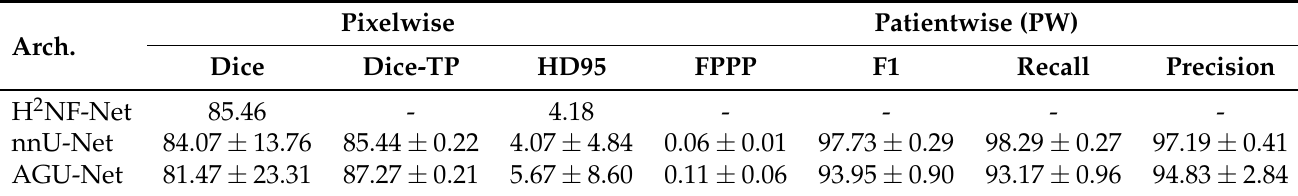
Table 4. Segmentation performances obtained over the GS2 subset with the two considered architectures and a baseline. The results are averaged from the three models trained following the custom validation protocol with P1 preprocessing. Arch.